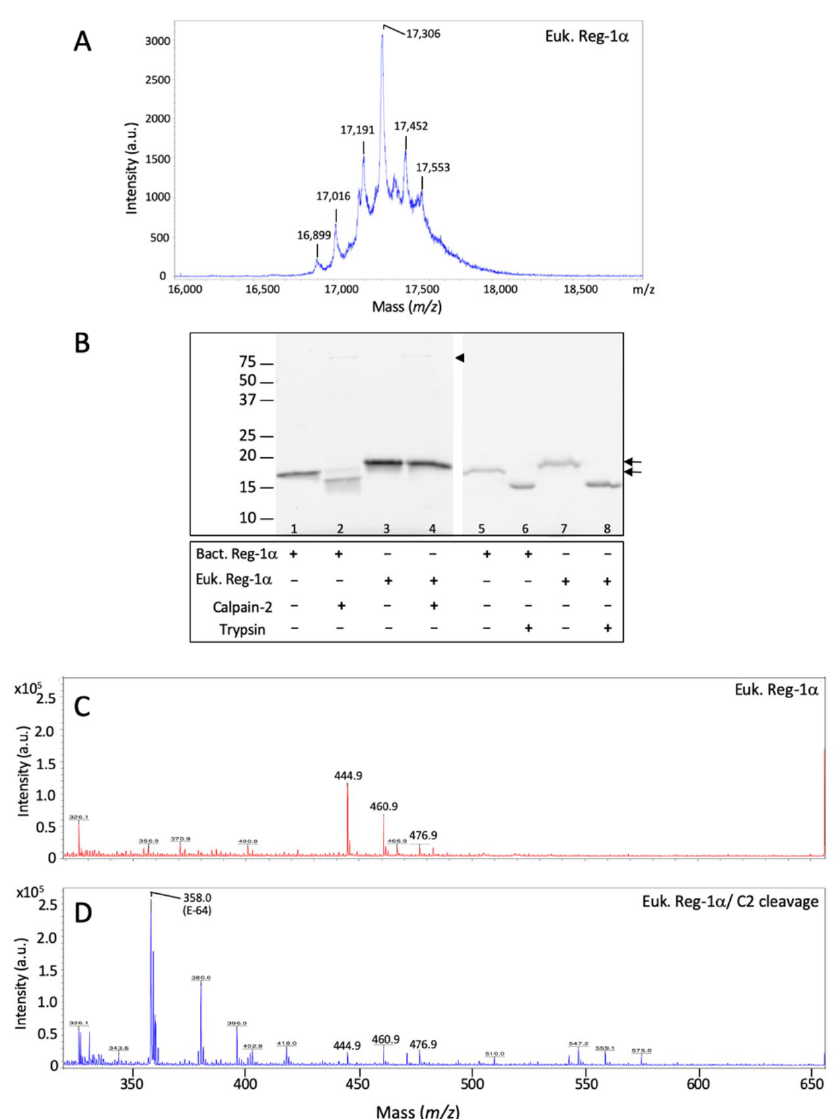
Figure 5. O-glycosylation of Reg-1 α protects it from the calpain-2-mediated cleavage in vitro. ( A ) MALDI spectra of the eukaryotic Reg-1 α (Euk. Reg-1 α ) obtained in the linear mode ( m/z 16,000– 19,000); ( B ) Both recombinant isoforms obtained from eukaryotic (Euk. Reg-1 α ) and bacterial (Bact. Reg-1 α ) sources were tested for calpain-2 (lanes 1–4) or trypsin cleavage (lanes 5-8) (ratio 1:10 and 1:100), respectively; samples were analyzed on 13.5% acrylamide gel and visualized using the Stain- Free Imaging Technology (see Section 4). Note that the protein from eukaryotic source displays a slightly higher molecular weight (see arrows) compared to the protein from bacteria due to the presence of glycosylation; arrowhead indicates the presence of calpain-2 (lanes 2,4). ( C , D ), MALDI reflectron mode spectra ( m/z 300–650) of the glycosylated form of Reg-1 α (Euk. Reg-1 α ) before ( C ) and after calpain-2 cleavage (Euk. Reg-1 α /C2) ( D ). The position of the calpain inhibitor (E-64)